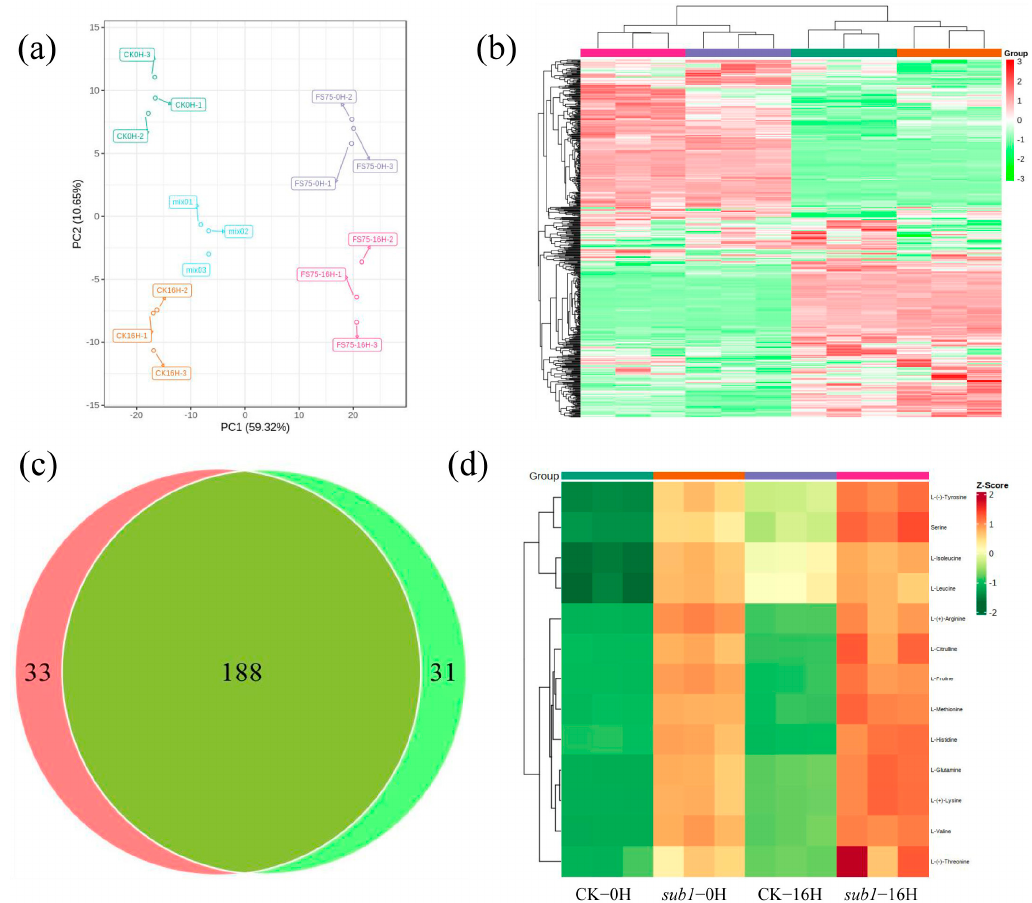
Figure 4. The quality of metabolome and differentially accumulated metabolites analysis. ( a ) PCA analysis, ( b ) heatmap of differentially accumulated metabolites, green represents down-regulated, red represents up-regulated, ( c ) Venn diagram analysis, ( d ) heatmap of differentially accumulated amino acids, green represents down-regulated, and red represents up-regulated. Table 4. Differentially accumulated carbohydrate compounds.